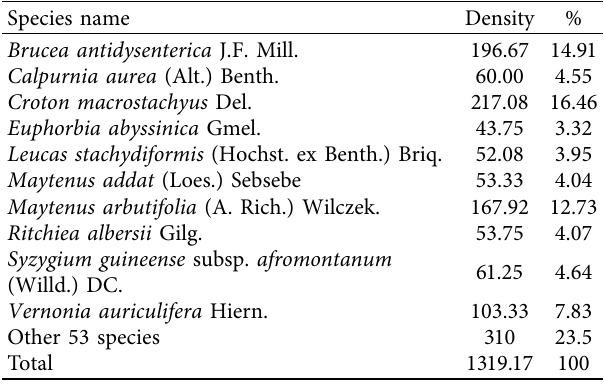
Table 2: Density (individuals ha − 1 ) and percentage contribution of ten most abundant woody species in Abbo Sacred Forest. Species